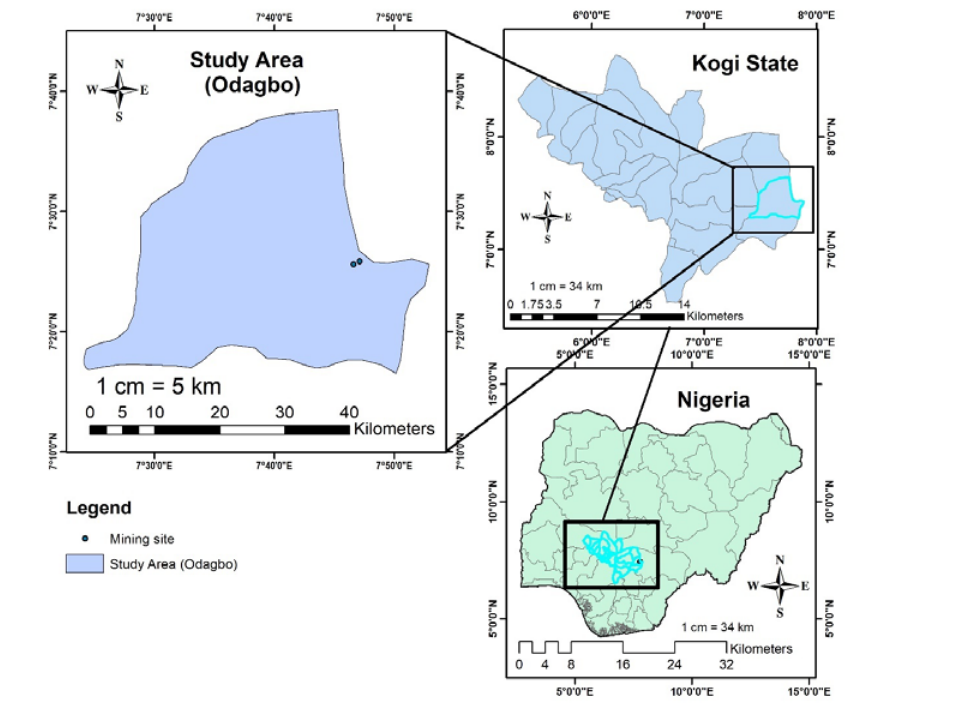
Fig. 1 Location of the Mining Site at Odagbo, Okaba